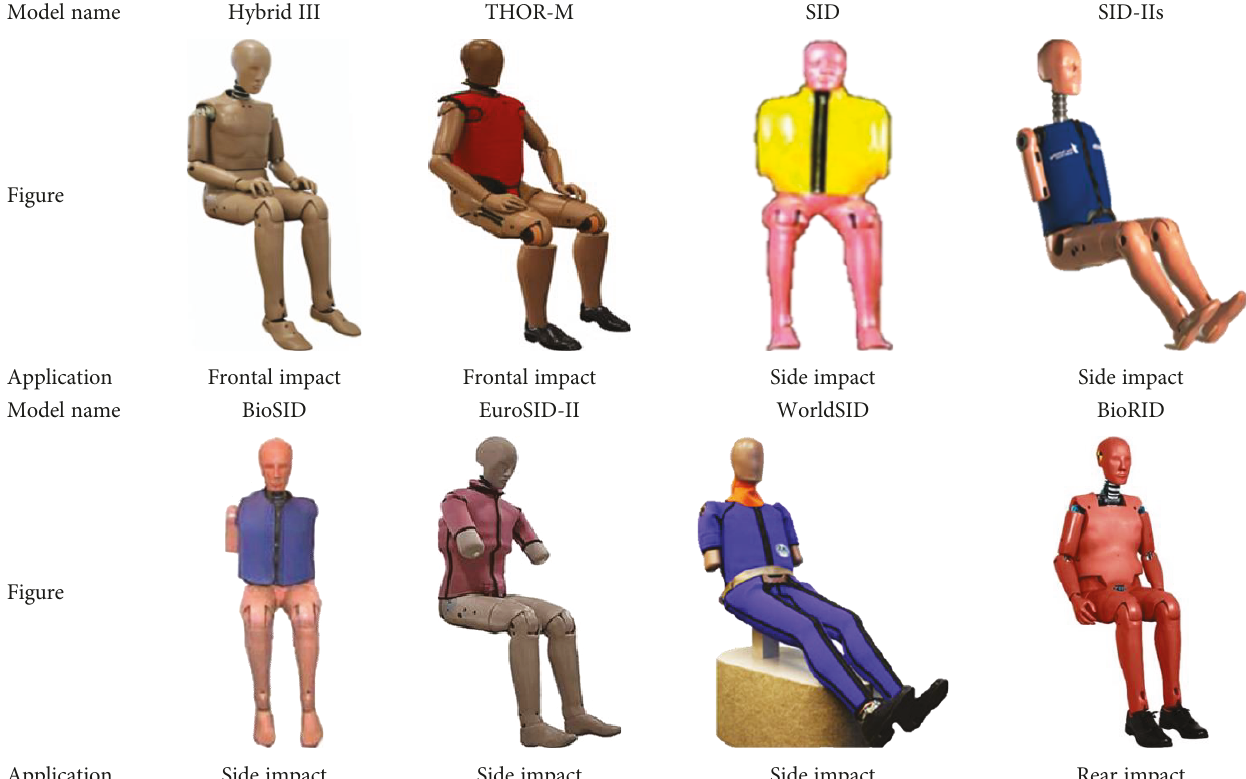
Table 3: Dummies and their application